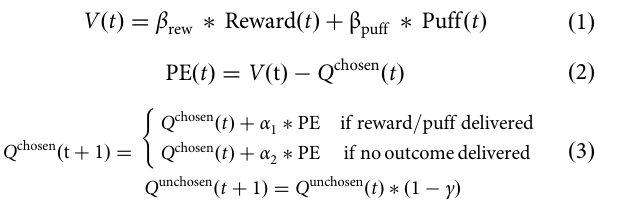
Fig. 2 Representations of action-reward – puff combinations by SPNs. a Imaging setup and preparation. b Example of imaging fi eld-of-view showing GCaMP6s-expressing neurons (green). tdTomato (red) expressed in the cell bodies and neuropil demarcates the striosome compartment. Seventy- fi ve of such fi elds-of-view were imaged in a total of 13 mice. c Two sample neurons during 10 min of recording. Neuronal transients occurred selectively for action – reward – puff associations during the outcome period. d Percentage (mean ± SEM) of neurons selectively responding to chosen action (left: 12.1 ± 1.4%, right: 7.8 ± 1.2%), reward outcomes (reward: 13.1 ± 1.8%, no reward: 22.7 ± 2.2%), and puff outcomes (puff: 23.0 ± 2.5%, no puff: 4.8 ± 0.6%). More neurons responded to the absence than to the presence of rewarding outcome ( p = 0.013, t = 2.89, n = 13 mice, two-sided paired t -test), and more neurons responded to the presence than to the absence of aversive puff outcome ( p = 0.00037, t = 6.34, n = 13, two-sided paired t -test). * p <